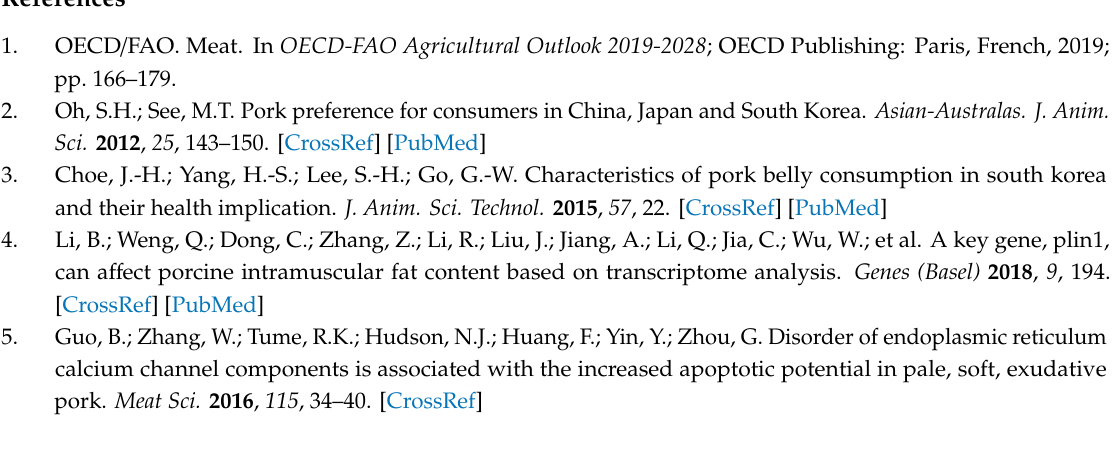
Table S1: Basic characteristics of the study all subjects, Table S2: Summary of gene expression and DEG information from loin muscle transcriptome, Table S3: Summary of enriched GO categories assigned to DEG’s, Table S4: Summary of enriched KEGG pathways assigned to